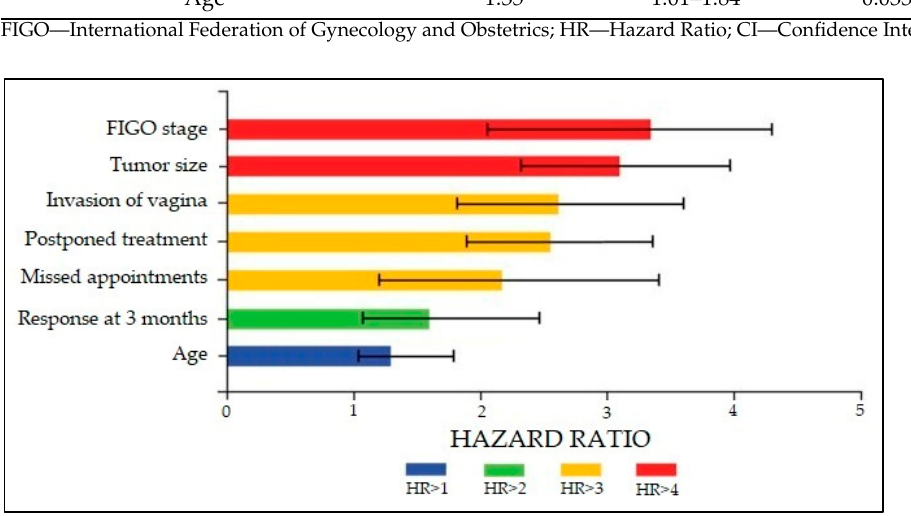
Figure 2. Graphical representation of risk factors for disease progression in patients with cervical cancer undergoing radiation therapy. The likelihood of disease progression reported as hazard ratio (HR) and confidence interval.